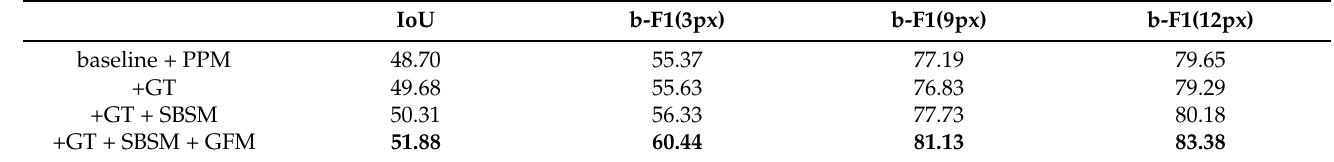
Table 6. Boundary F1 score. The bold values in each column means the best